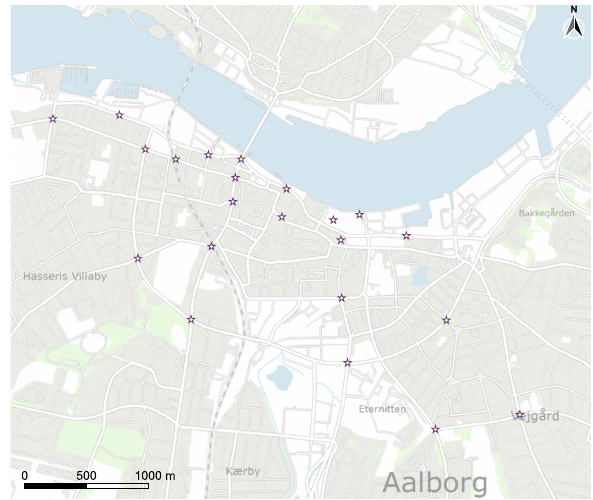
Figure 3. Map showing the location of 22 of the MONTEM CityProbes in Aalborg. The last 3 CityProbes in the network are placed in the outskirts of Aalborg where the main university campus is situated.